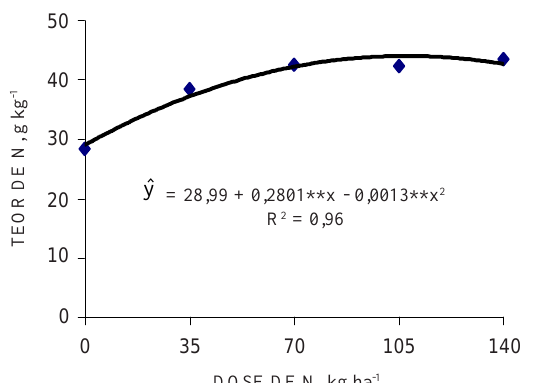
y = -0,0013x 2 + 0,2801x + 28,985